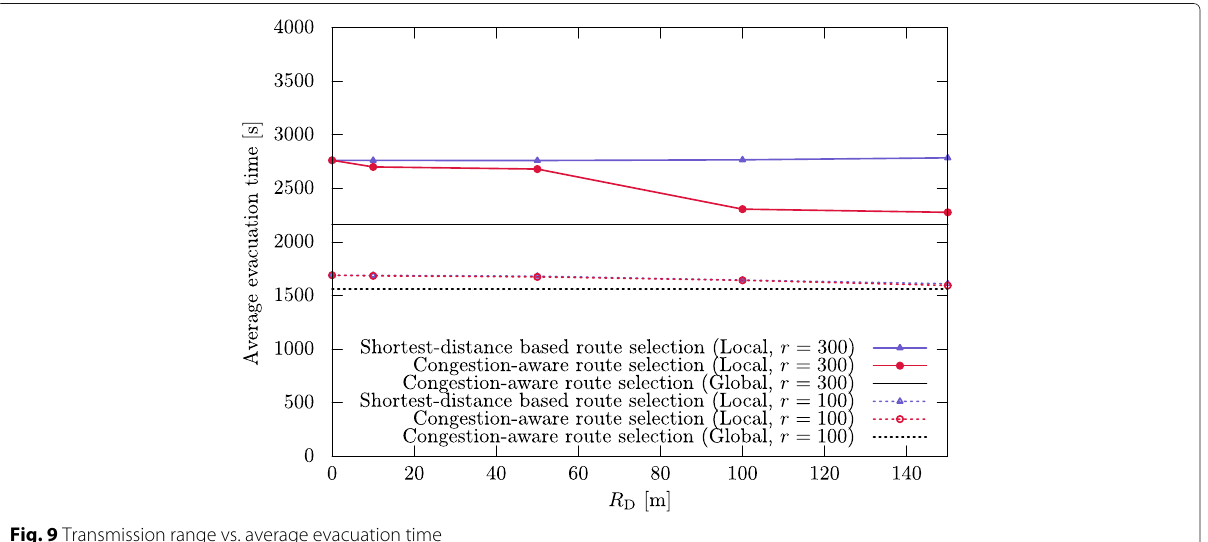
Fig. 9 Transmission range vs. average evacuation time